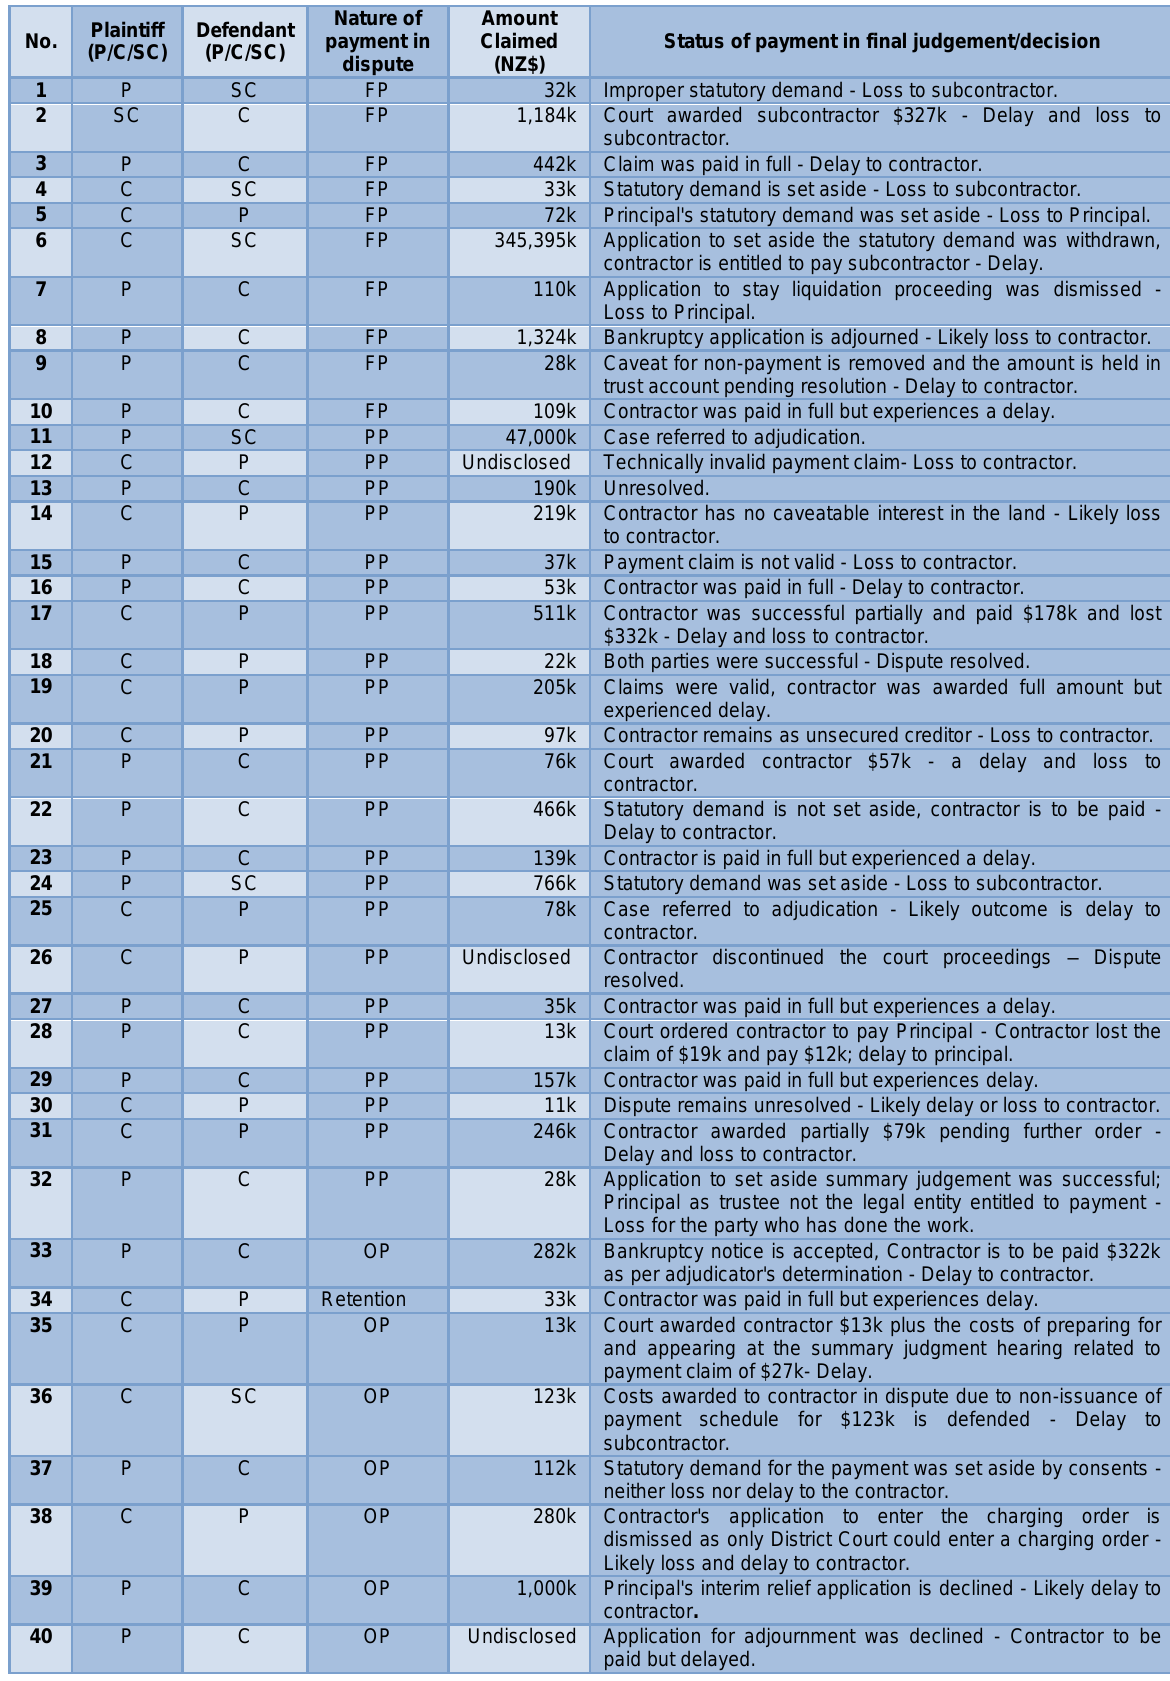
Table 2 Summary of construction payment